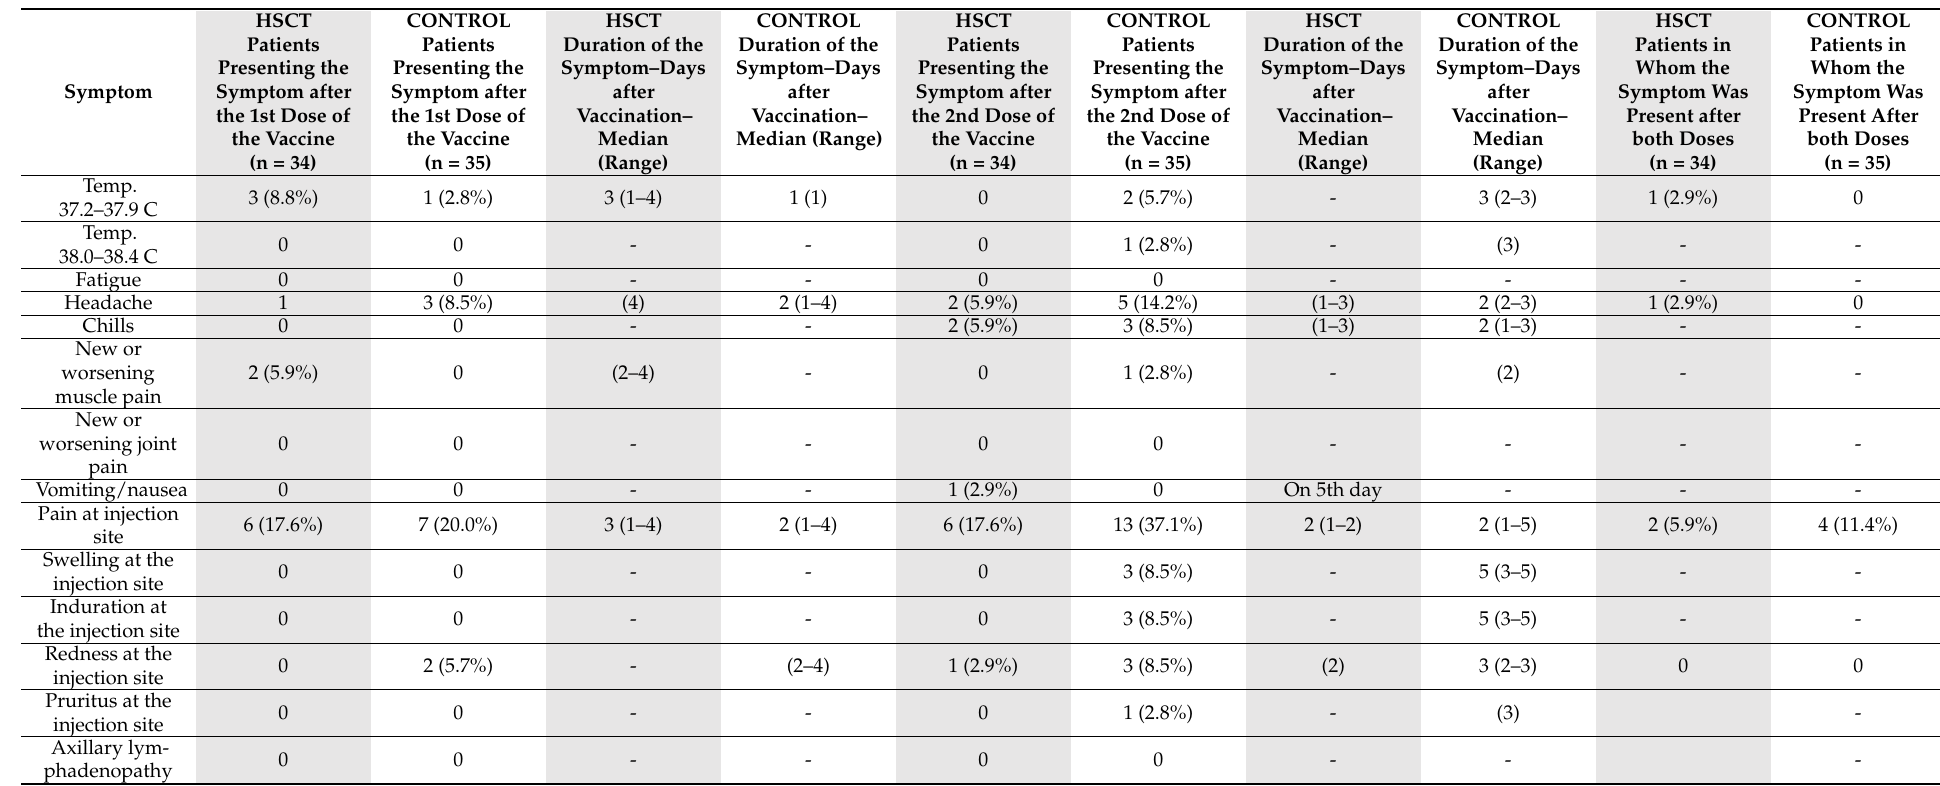
Table 5. Adverse events in the allo-HSCT and control groups (the white colour—HSCT group, the grey colour—CONTROL